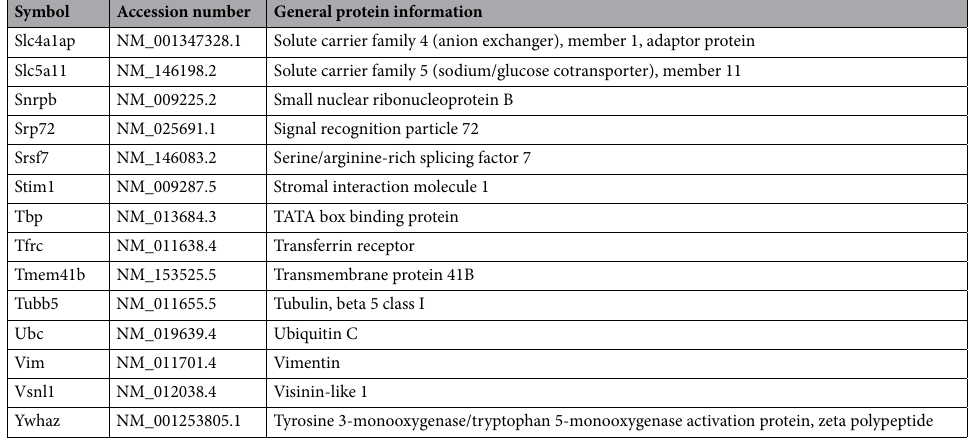
Table 1. Summary of 70 housekeeping genes evaluated in this study. Gene symbol, accession number and general protein information are shown.